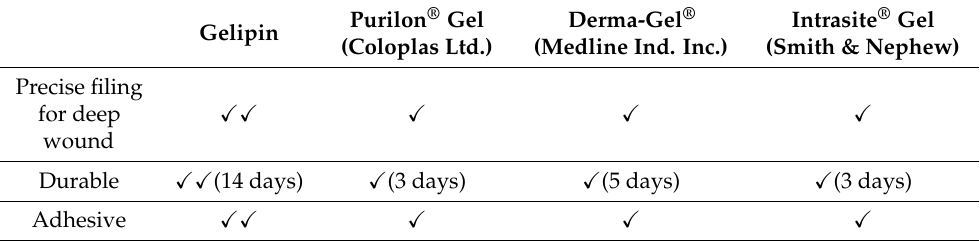
Table 1. Comparison of gelipin with commercially available